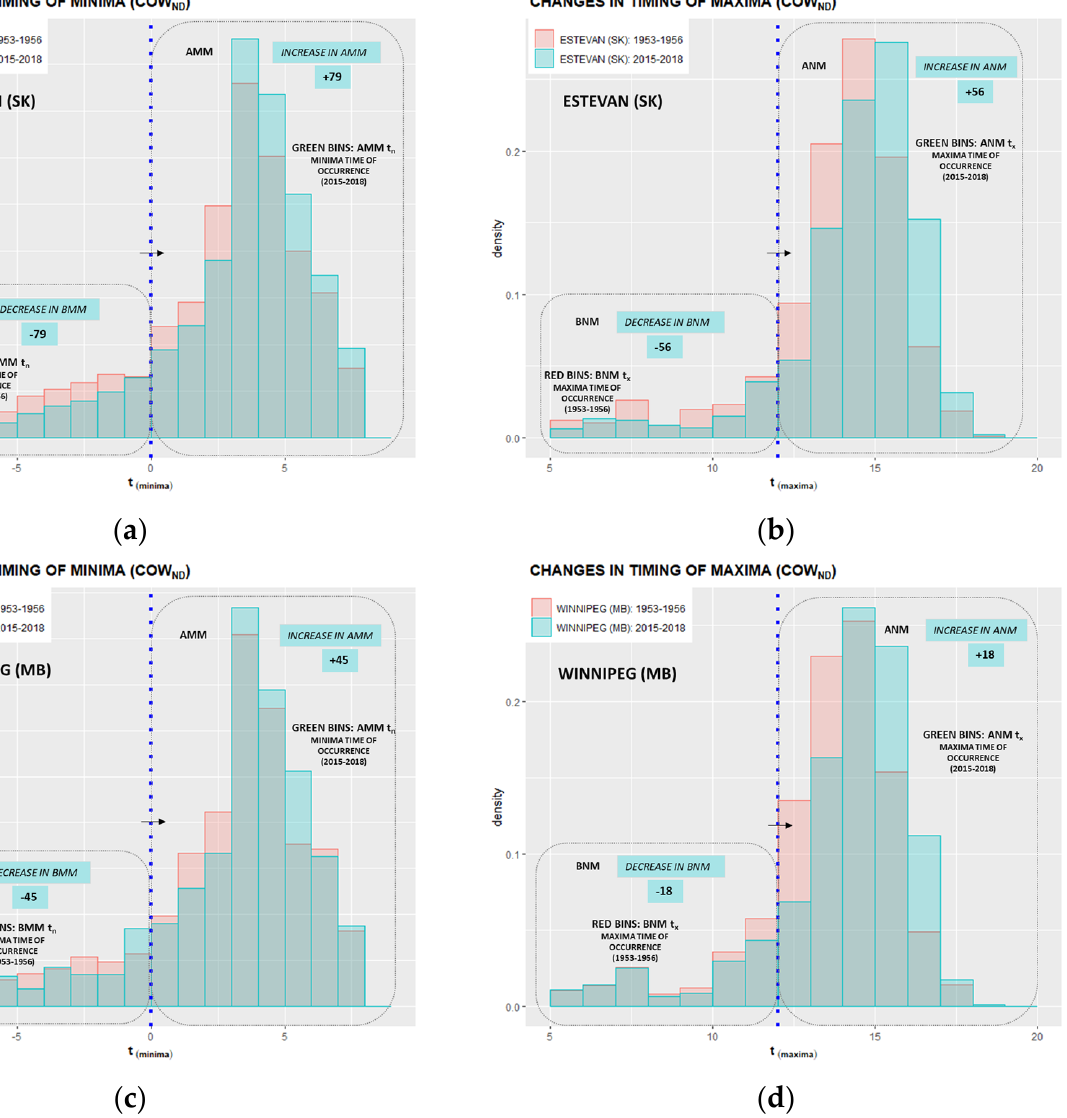
Figure A16. Prairies climate region: Estevan (SK) and Winnipeg (MB). Time evolution of the Diurnal Extrema Timing (DET) histograms at Estevan ( a , b ), and Winnipeg ( c , d ) stations. Migration of the Before Midnight Minima (BMM) to After Midnight Minima (AMM) and migration of the Before Noon Maxima (BNM) to After Noon Maxima (ANM) between four-year averages at the beginning (1953–1956) and ending (2015–2018) of data ranges. The blue dotted line represents midnight delineation ( left ) and noon delineation ( right ).